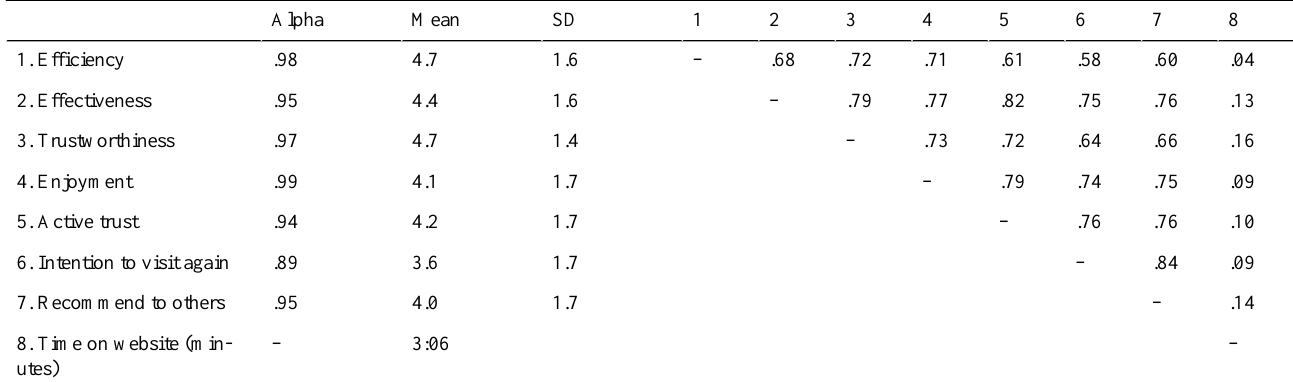
Table 1. Correlation matrix intervention 1 (N = 343)